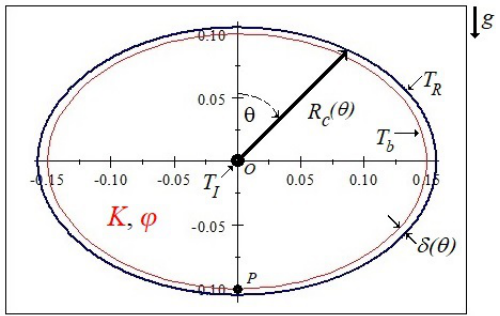
Figure 2. Cross-section of the steam chamber subject to gravity action. In this work, the elliptical chamber is characterized by the equation r = R c ( θ ) , Equation (4), where the location of the injection pipe is O and that of the production pipe is P . The inner region of the ellipse is a homogeneous porous medium of permeability K and porosity ϕ . Meanwhile, the temperature of the injection of steam is T I , the boiling temperature of the phase change is T b , and the overall reservoir temperature is T R . Once the condensation of steam occurs, the water drains down through the slim layer of thickness, δ ( θ )